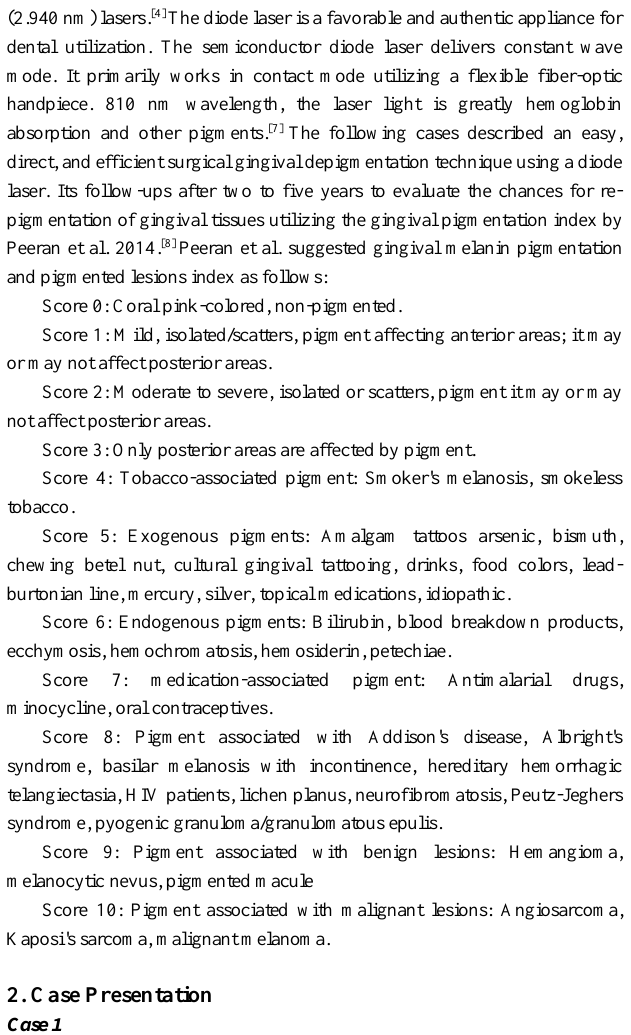
Fig. 3. Follow-up of upper arch depigmentation.